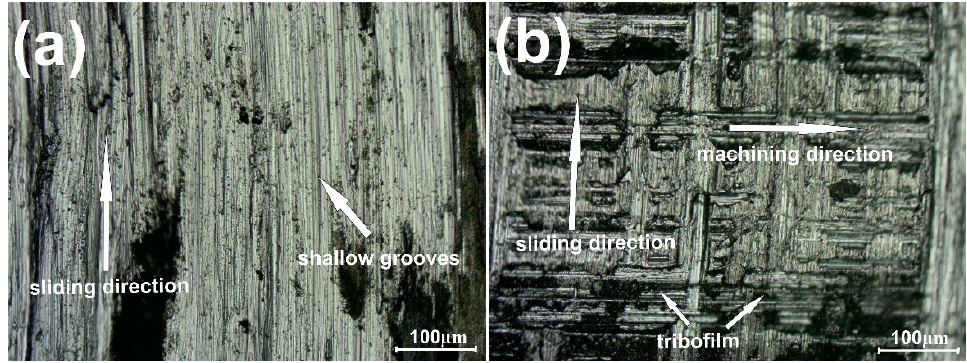
Figure 5. Surface condition of the counter-specimen mating with Ni-50%NiCr(80/20) ( a ) and Ni-